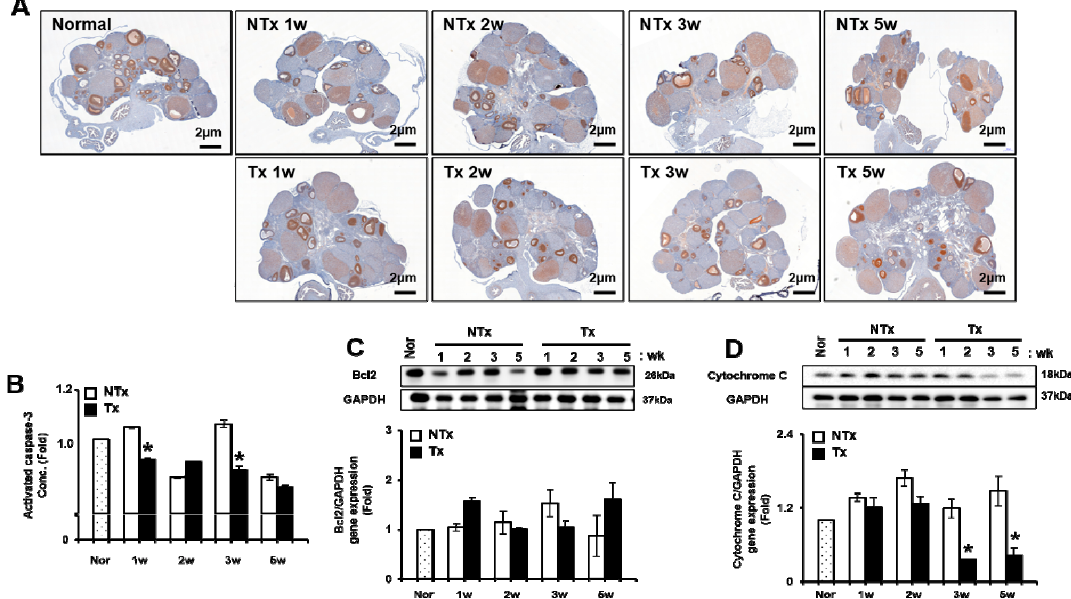
Figure 4. Effect of PD-MSCs transplantation on apoptosis in the ovary tissues of the OVX rat model. The PCNA expression in follicles of the ovary was stained by immunohistochemistry ( A ). The activated caspase-3 levels in the serum of NTx and Tx groups were analyzed by the ELISA assay ( B ). Bcl2 and cytochrome C gene expression were analyzed by western blot ( C , D ). The data are representative of three independent experiments and expressed as means ± SD. * p < 0.05: NTx vs. Tx.